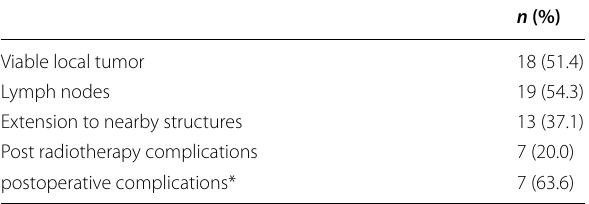
*Percentage was calculated based on total 11 patients underwent surgery